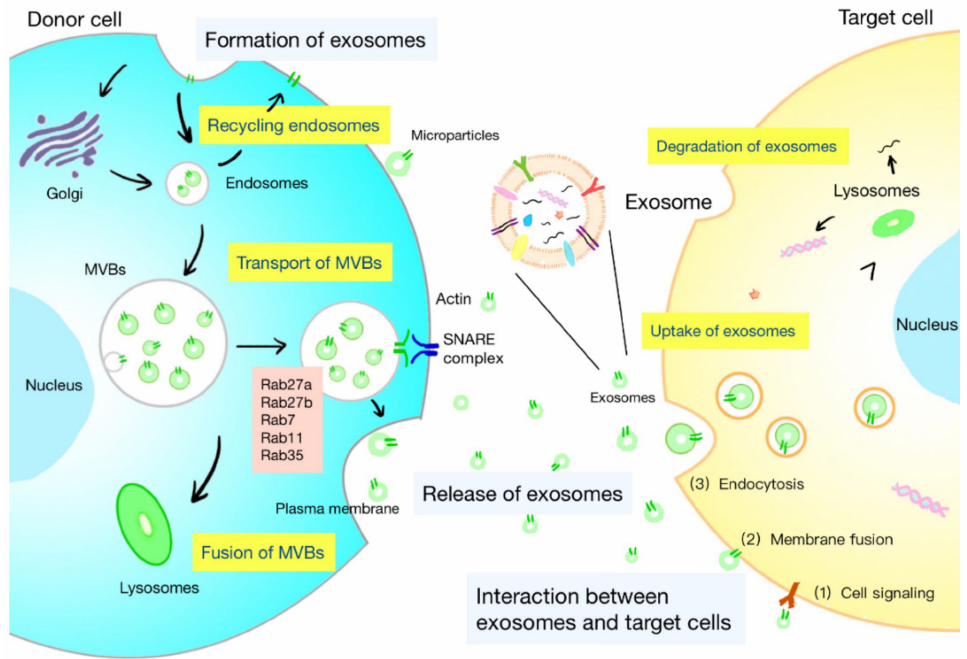
Figure 1. Life course of exosomes. The formation of exosomes: initiation, endocytosis, multivesicular bodies (MVBs) formation, and secretion. The intracellular trafficking of MVBs is mediated by Rab GTPases. The fusion of MVBs with the plasma membrane is facilitated by SNAREs. There are three kinds of interactions between exosomes and cells: (1) the membrane proteins on the exosomes and target cells bind directly, and then trigger the intracellular signaling cascade; (2) exosomes transport their contents to target cells by fusing with the cell membrane; and (3) exosomes are engulfed by cells and degraded by lysosomes to release signal